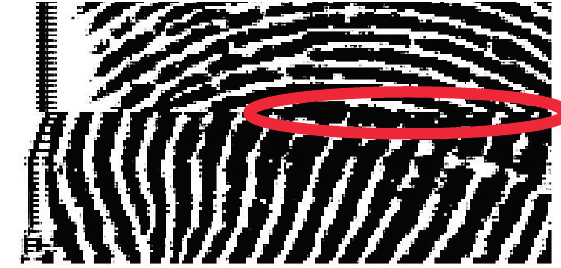
Figure 4. Large segment of continuing black pixels in a row due to smeared noise in a truncated fingerprint.